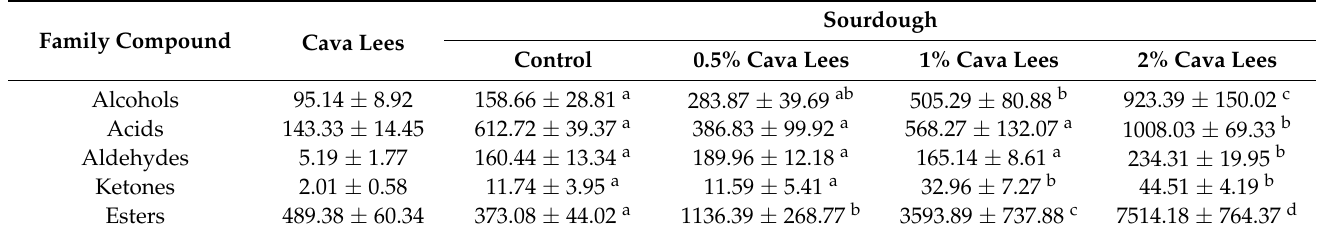
Table 1. Concentration (mg/kg) of total volatile compounds classified by the chemical family obtained with the optimized HS-SPME method in Cava lees and